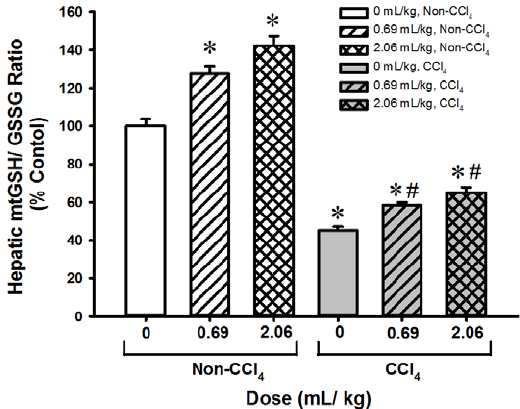
Figure 6. Effects of SOD-Like Supreme treatment on hepatic mitochondrial GSH/GSSG ratio in CCl 4 -challenged mice. After the SOD-Like Supreme treatment in CCl 4 -challenged mice, hepatic mitochondrial GSH/GSSG ratios were measured as described in Materials and Methods. The GSH/GSSG ratio of the non-CCl 4 control group is 14.7 ± 0.6 (mean ± SEM). Data are expressed as % of the non- CCl 4 control by normalizing relative to the value of the non- CCl 4 control group. Values given are means ± SEM, with n ≥ 9. * Significantly different from the non -CCl 4 controls; # Significantly different from CCl 4 control group.